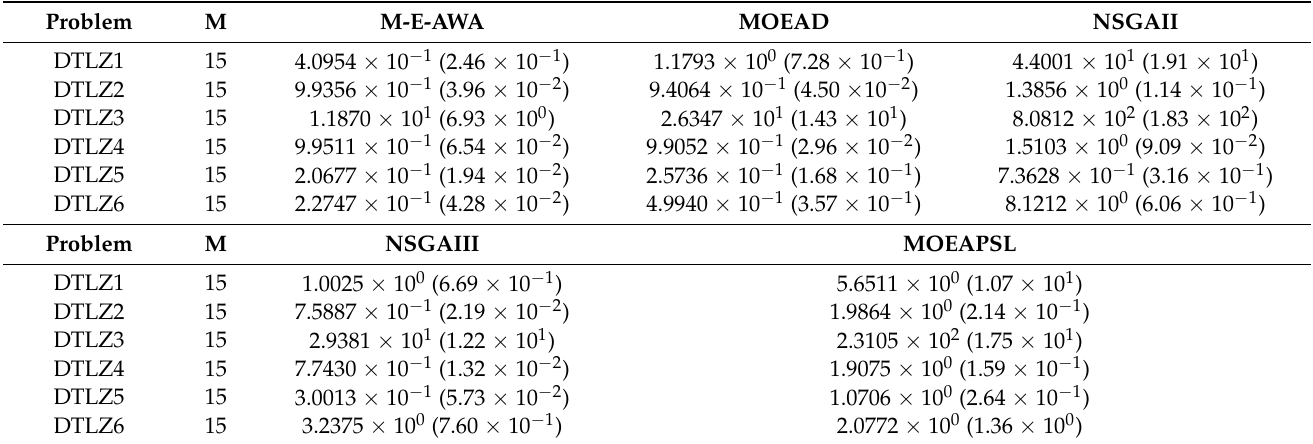
Table 5. Comparison of IGD values between M-E-AWA and contrast algorithms on DTLZ1– DTLZ6(The target number is 15).